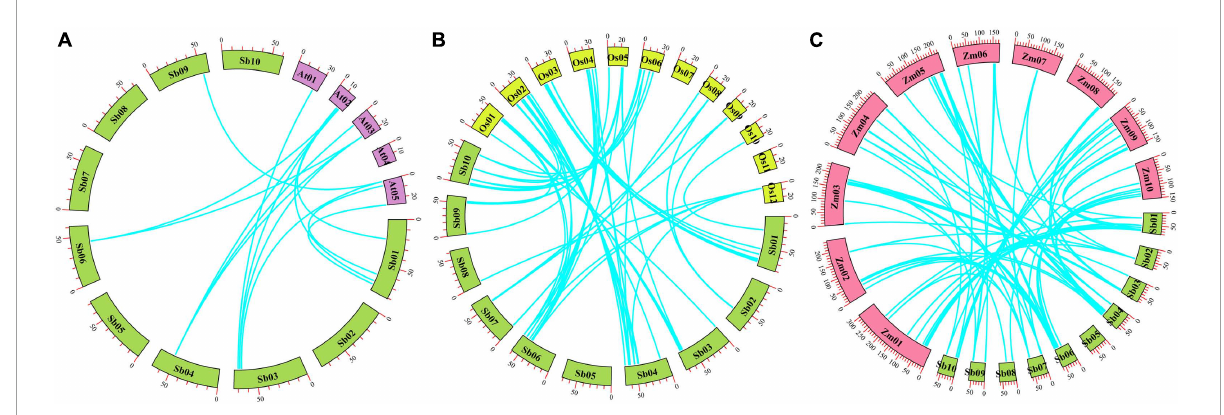
FIGURE4 Collinear block identification of sorghum and Arabidopsis , rice, and maize U-box genes. (A) Collinearity relationships between U-box genes in sorghum and Arabidopsis thaliana ; (B) collinear relationships between U-box genes in sorghum and rice; (C) collinearity relationships between U-box genes in sorghum and